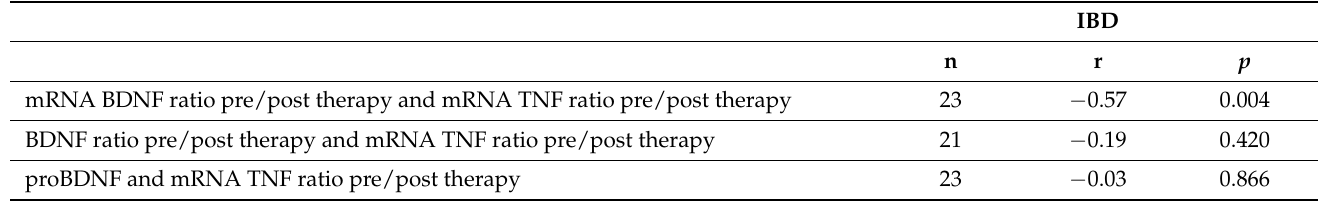
Table 7. Correlations between changes in neurotrophin expressions and tumor necrosis factor mRNA expression after biological